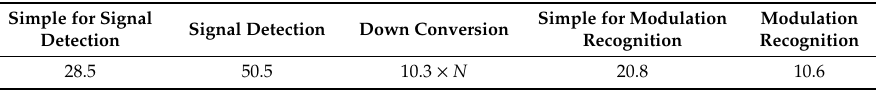
Table 1. The time complexity of the DL framework